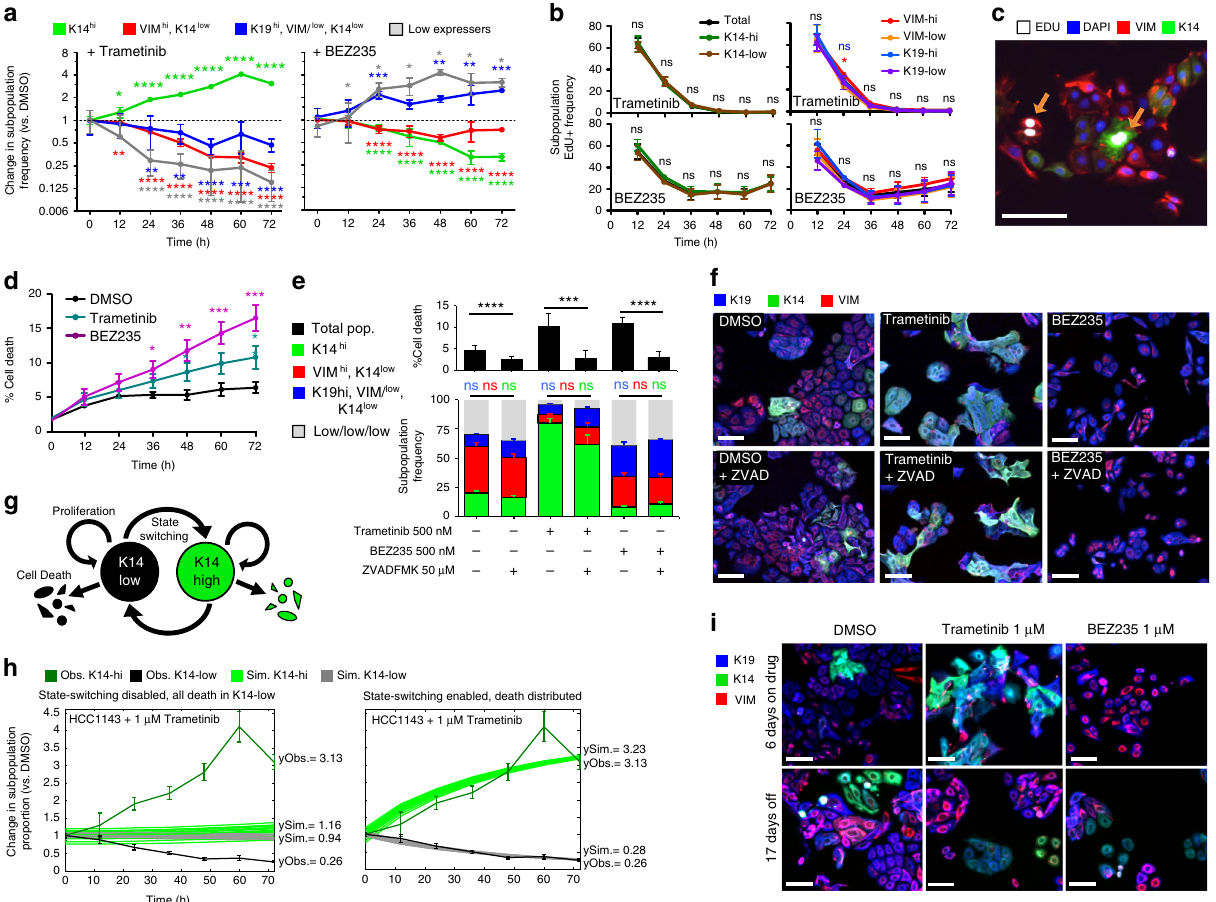
Fig. 3 Cell state transitions underlie DTP-state enrichment. a Graphs showing change in frequency (vs. DMSO) of four differentiation states de fi ned as K14 hi (green), VIM hi /K14 low (red), K19 hi /VIM low /K14 low (blue), and K19 low /VIM low /K14 low (gray) following exposure to 1 μ M Trametinib or BEZ235. Asterisks depict signi fi cant gains or losses in state frequency vs. 0 h, * P < 0.05, ** P < 0.01, *** P < 0.001, **** P < 0.001, n = 15 with SD. b Graphs showing percent of EdU + cells expressing high or low levels of K14, K19, or VIM following treatment with 1 μ M Trametinib or BEZ235, ns = not signi fi cant, SEM shown. c IF image showing both K14 hi and K14 low cells positive for EdU-incorporation following 36 h of Trametinib treatment, scale bar = 100 μ m. d Graph showing percent of YO-PRO-1 + dying cells following treatment with 1 μ M Trametinib or BEZ235, n = 8 with SEM. e Graphs showing the percent of dying cells (top) and the frequency of cells in four differentiation states (bottom, de fi ned and colored as in ( a )) following 72 h exposure to Trametinib, BEZ235, or DMSO + / − the pan-caspase inhibitor Z-VAD-FMK. No signi fi cant (ns) differences observed in differentiation-state frequency + / − Z-VAD-FMK, n = 12 with SD. f IF images of remaining HCC1143 cells in ( e ) following 72 h exposure to Trametinib, BEZ235 or DMSO + / − Z-VAD-FMK. Scale bars = 100 μ m. g Schematic of cell-state behavior where cells can transition between K14 hi and K14 low cell states and undergo death or proliferate in either state. h Simulated fold change of K14 hi (bright green) and K14 low (gray) cell-state proportions over 72 h following treatment with 1 μ M Trametinib (vs. DMSO) are overlaid with experimentally observed average fold change (vs. DMSO) of K14 hi (dark green) and K14 low (black) cell-state proportions. ySim denotes simulated endpoint values; yObs denotes observed endpoint values. Two simulations with different cell-switching and cell death parameters shown: K14 hi Darwinian selection (left, Trametinib kills only K14 low cells, and cell-state transition is inhibited) and Transition-mediated (right, Trametinib kills K14 low and K14 hi cells in equal proportions, cell-state transition is allowed). i IF images of HCC1143 cells following 6 days of 1 μ M Trametinib or 1 μ M BEZ235, then following 17 days of culture without drug. scale bars = 100 μ